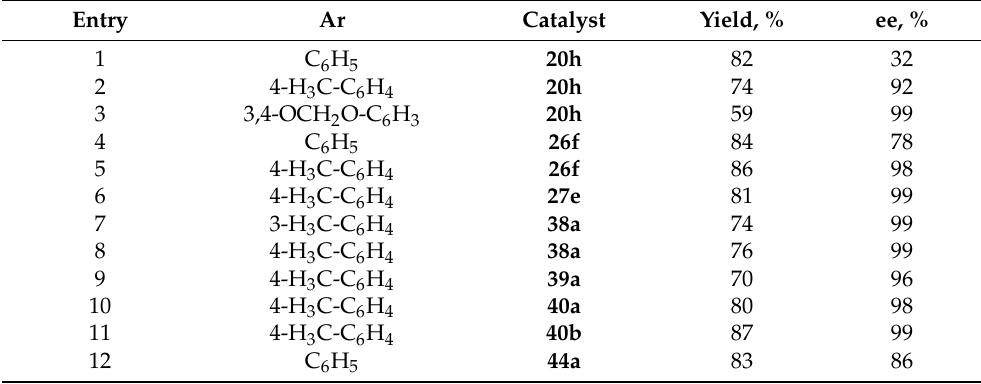
Scheme 14. Michael-initiated ring closure reaction of arylidenemalononitriles ( 65 ) and diethyl bromomalonate ( 63 ). Table 7. Effect of crown ethers in the MIRC reaction of arylidenemalononitriles ( 65 ) and diethyl bromomalonate ( 63 ).